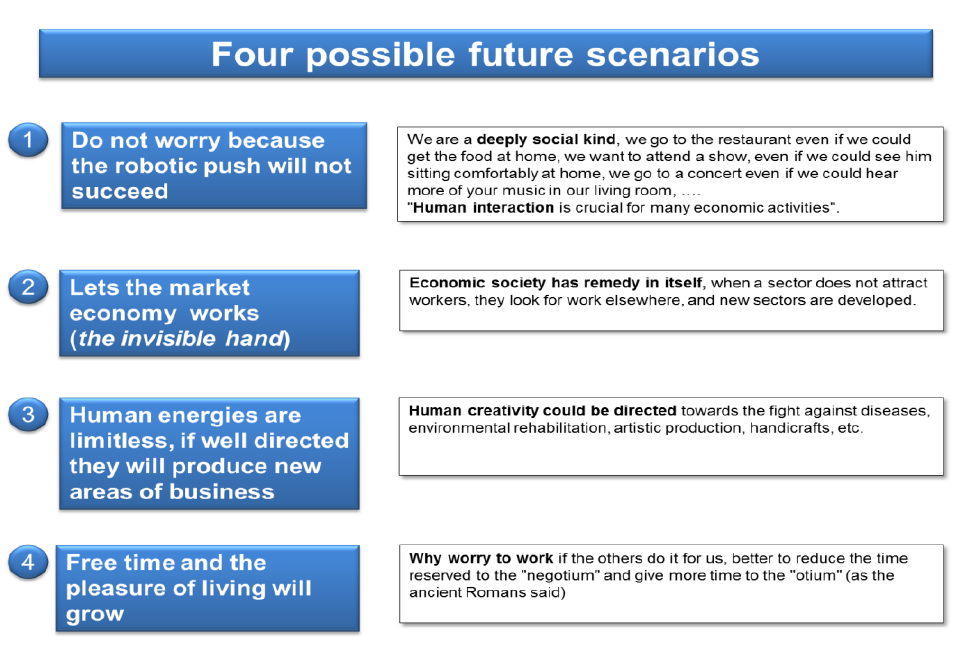
Figure. 1. The Future of Work in the Academic